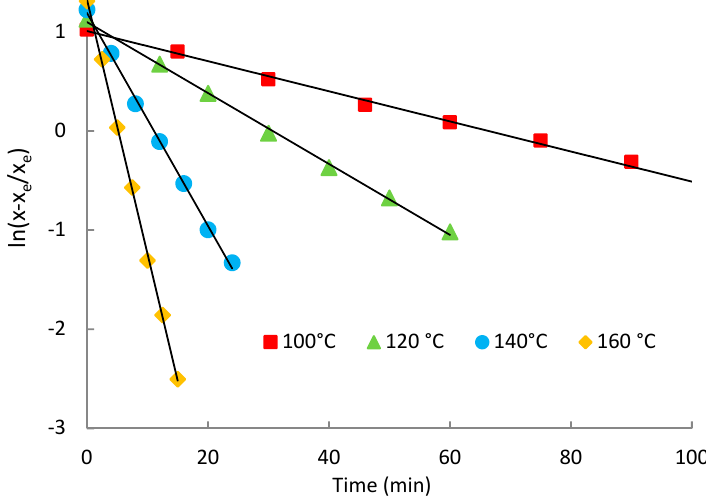
Figure 6. Linearized dependence of ethanol concentration on time during the transesterification of oligomeric lactic acid with ethanol.